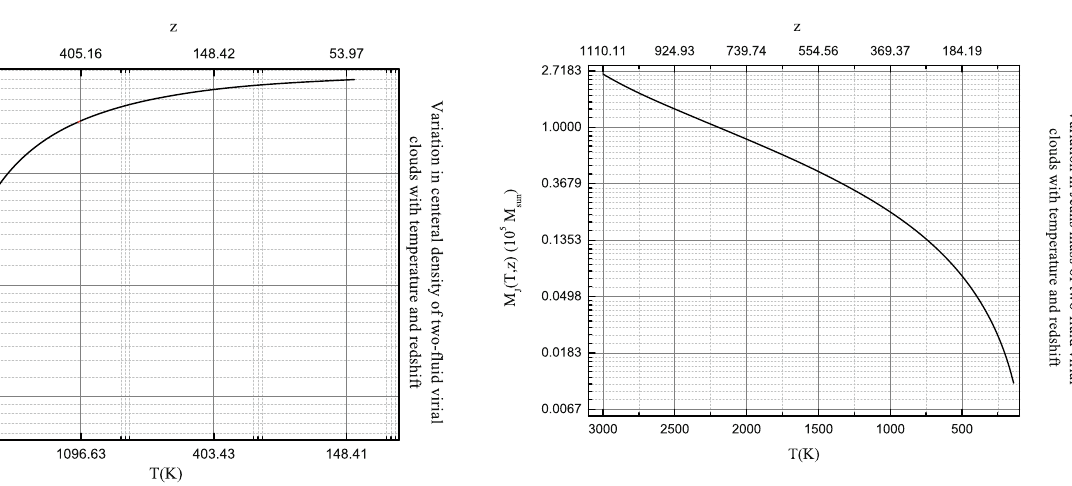
Fig. 5 Variation in the Jeans mass of the virial clouds constituted by cosmological primordial fraction of H and He